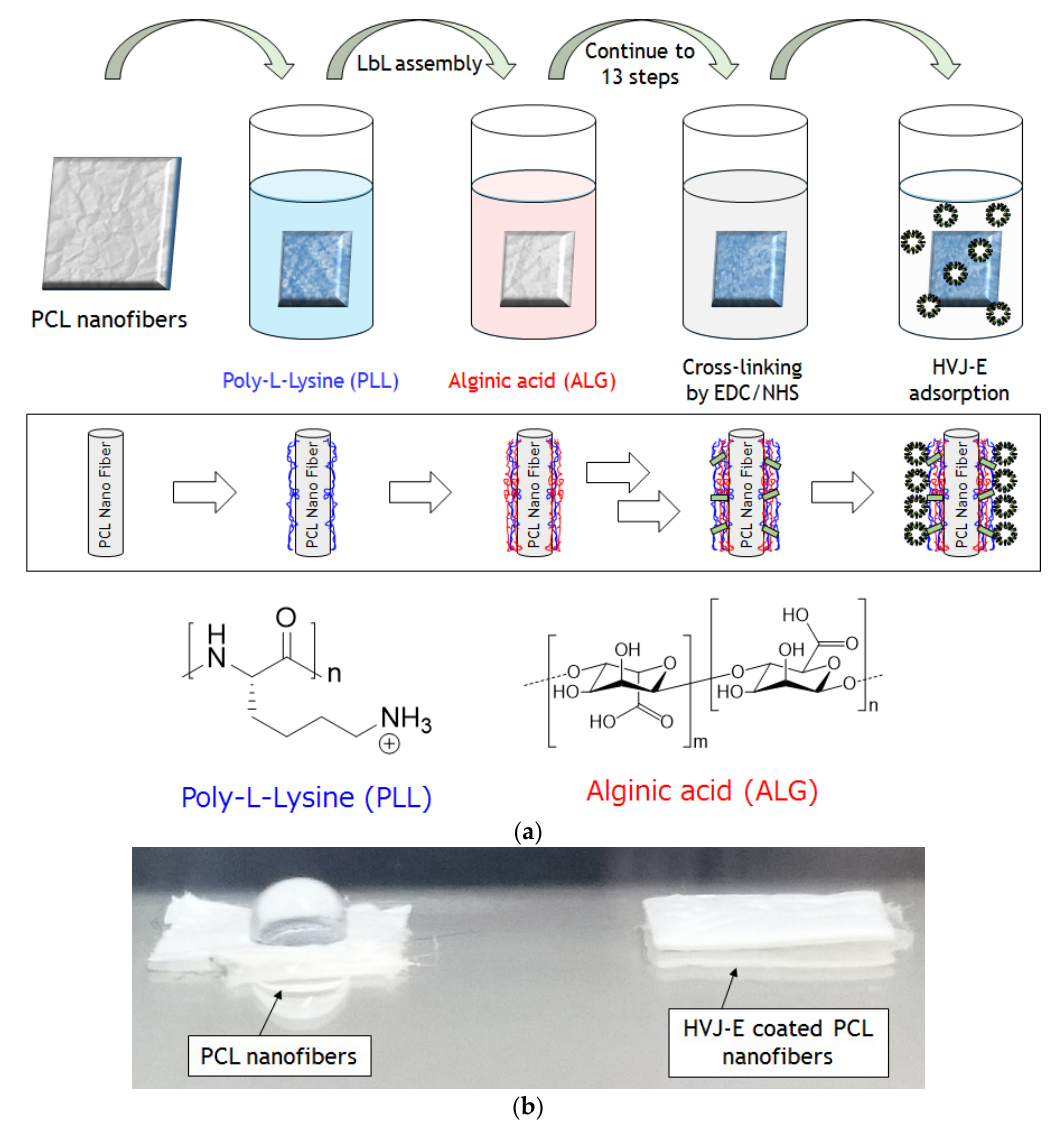
Figure 2. ( a ) Layer ‐ by ‐ Layer coating on PCL nanofibers with poly ‐ L ‐ Lysine (PLL) and alginic acid (ALG) via alternative deposition of polymers. After LbL coating, the fibers were crosslinked by EDC/NHS. HVJ ‐ E was then adsorbed on the PLL outermost surface; ( b ) Photograph of water droplet on the PCL nanofiber mesh with (right) and without (left) HVJ ‐ E immobilization.